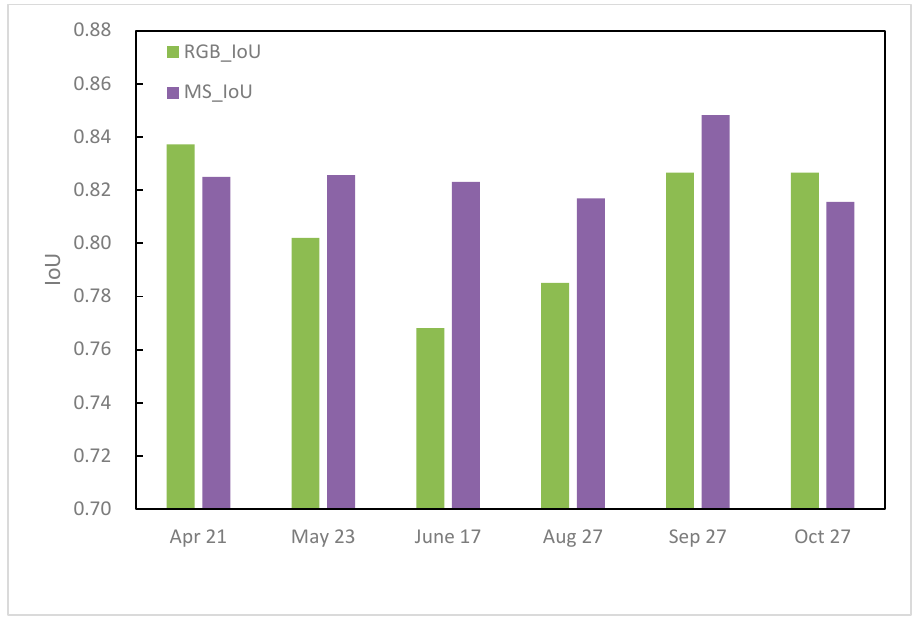
Figure 7. Comparison of the IoU for the RGB and MS models for di ff erent months.